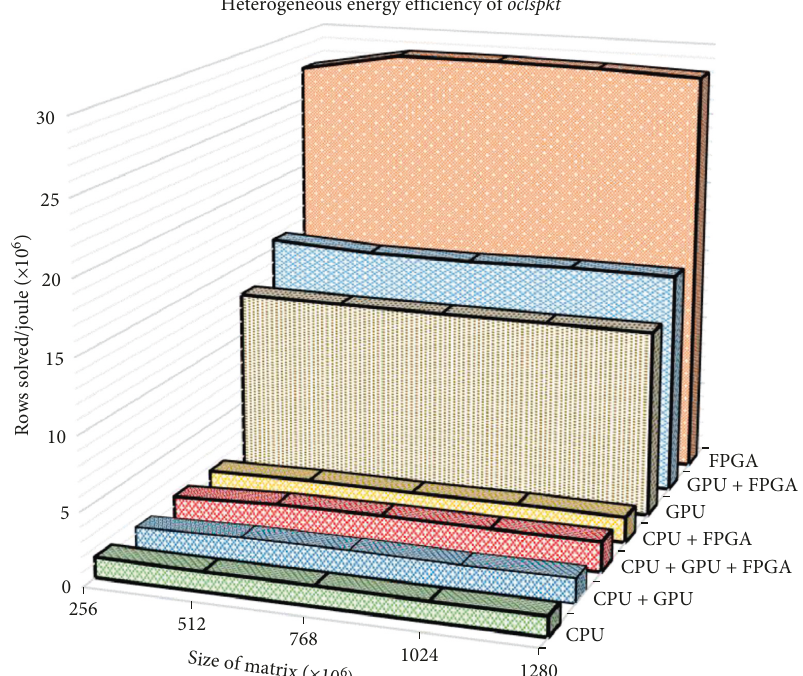
Figure 11: Estimated energy efficiency: comparison in rows solved per second for N � ( 256 ... 1280 ) × 10 6 for oclspkt when targeting CPU, GPU, FPGA, and heterogeneous combinations of